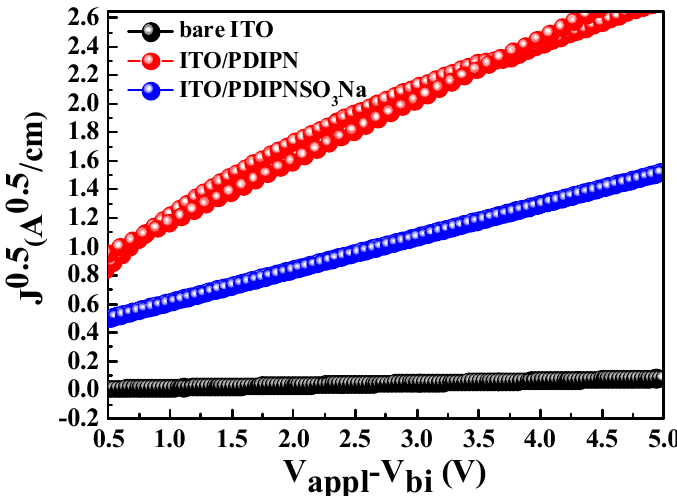
Figure 9. J 0.5 − V characteristics of electron-only devices ITO/ETLs/P3HT:PC 61 BM/Al with bare ITO, ITO/ PDIPN and ITO/ PDIPNSO 3 Na ETLs.